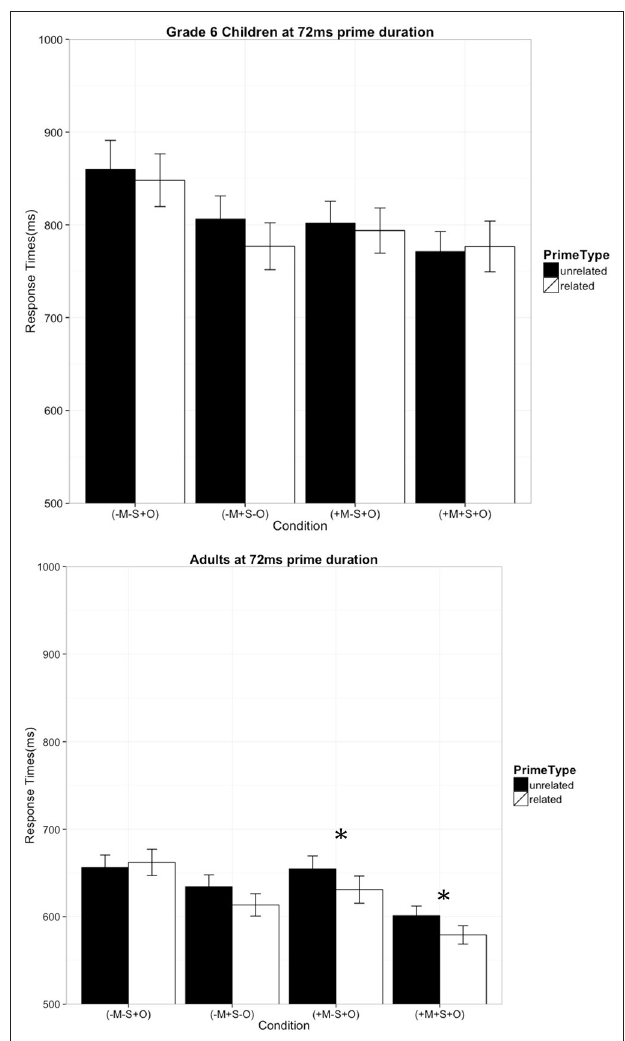
FIGURE 4 | Priming effects in reaction times in Experiment 4 (* p <